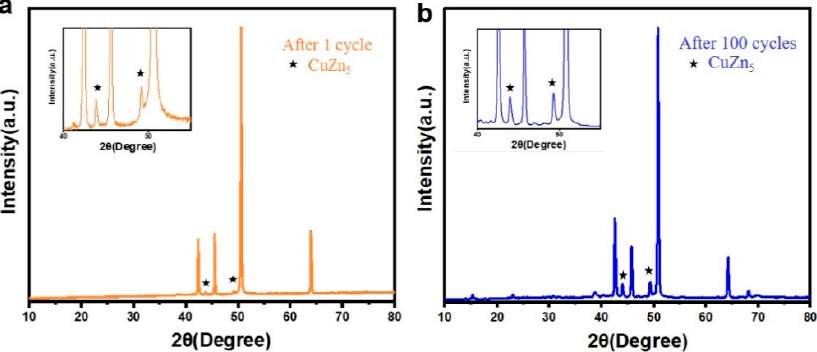
Figure 7. XRD pattern of Cu–Zn ( a ) after 1 cycle and ( b ) after 100 cycles at current density of 5 mA cm − 2 with a capacity of 1 mAh cm − 2 . ★ represents the XRD peak of CuZn 5 .